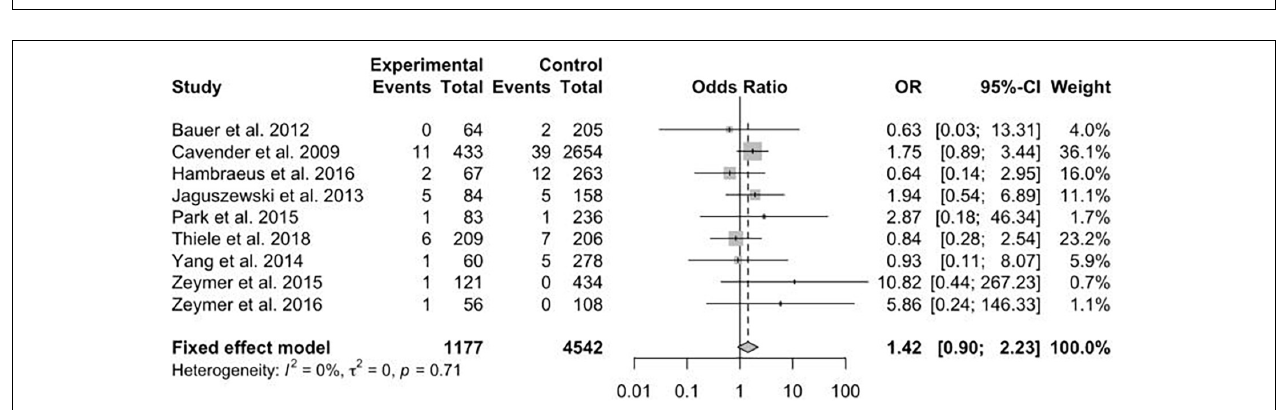
FIGURE 8 | Bleeding with multivessel (MV) vs. culprit vessel-only (CO) percutaneous coronary intervention (PCI) in patients with ST-segment elevation myocardial infarction (STEMI) complicated by cardiogenic shock (CS).